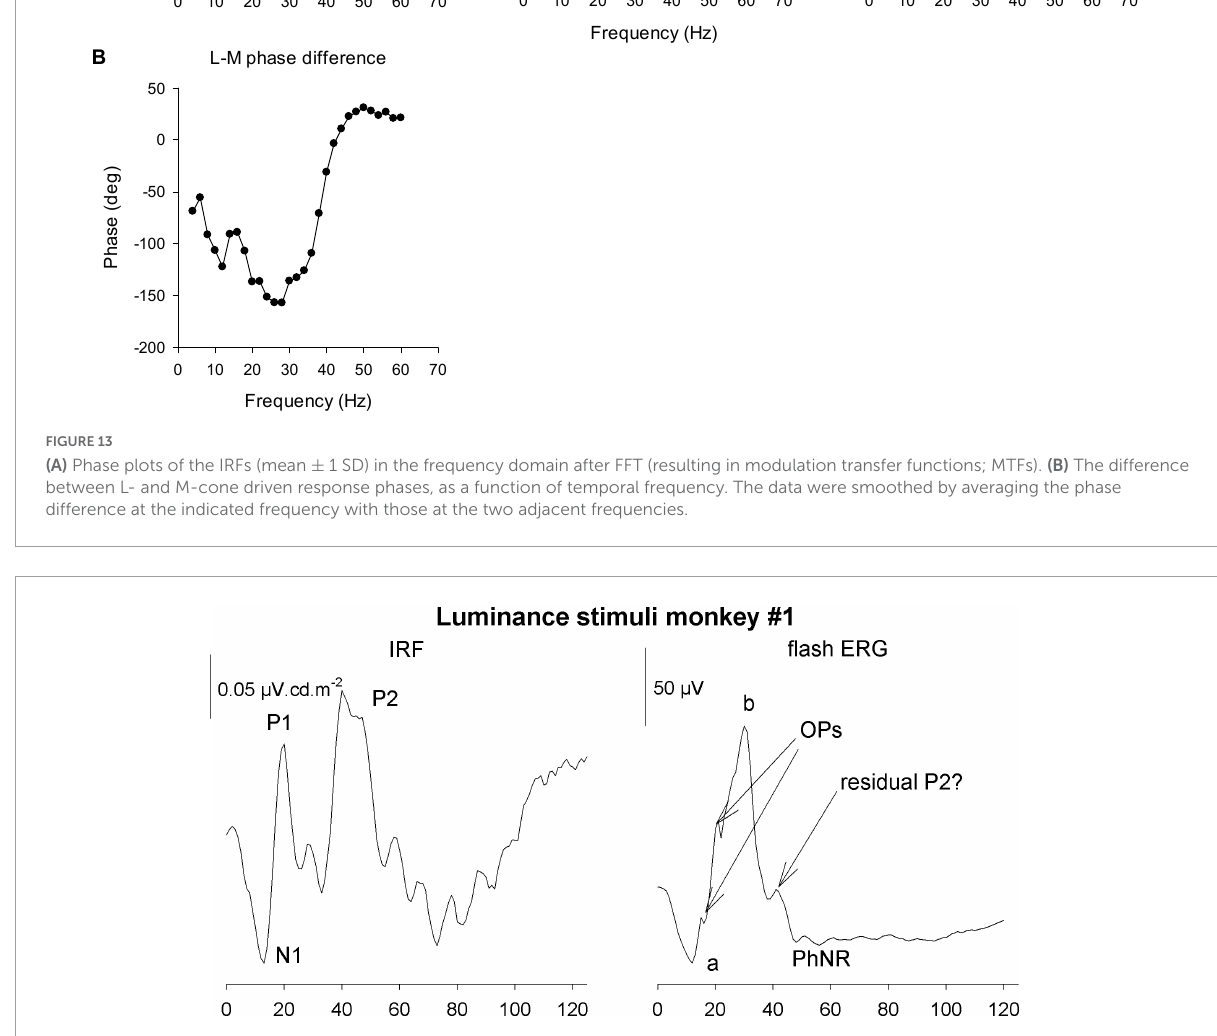
and that, as in human subjects, the macaque retina is L-cone